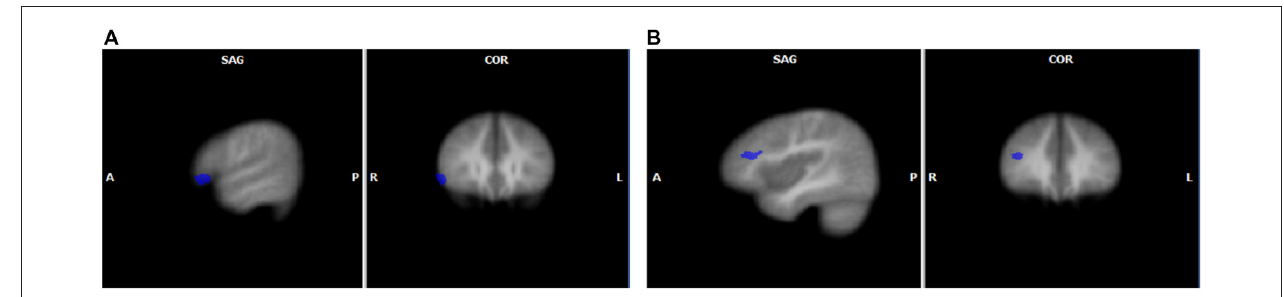
FIGURE 2 | Unisensory group effects for speech sounds with increased activation in FHD+ compared to FHD − children in the right inferior frontal gyrus (A) and in the right middle frontal gyrus (B) . The clusters are displayed on average brain from all participants at voxel-wise threshold of p < 0.01, corrected for multiple comparisons using cluster extent threshold of p < 0.05.